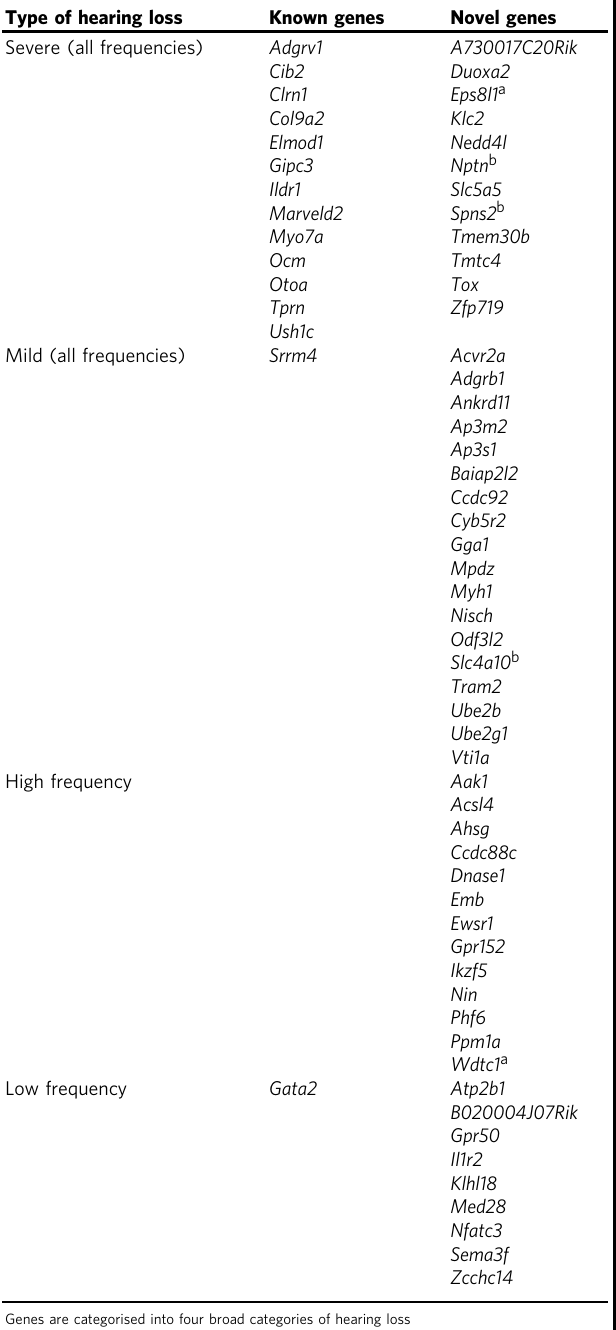
Table 1 Summary of known and novel hearing loss genes identi fi ed in the IMPC hearing loss